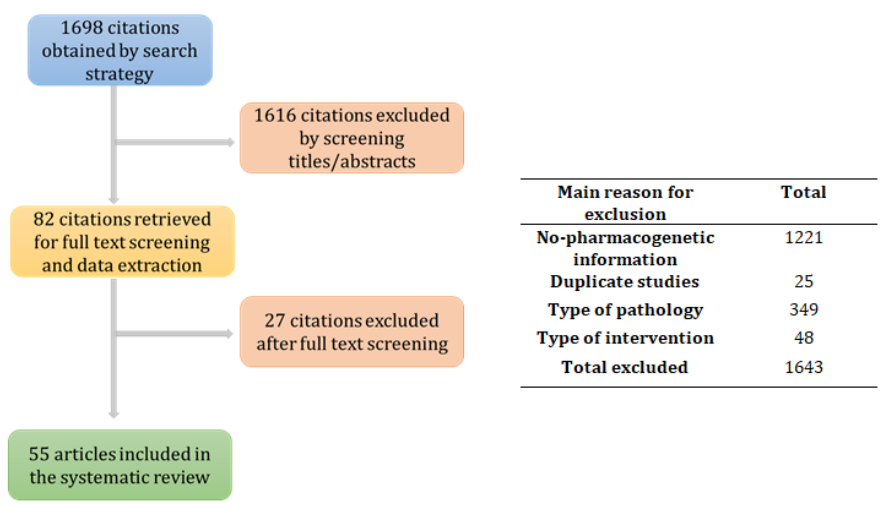
Figure 1. Flowchart of study selection procedure and main reasons for article exclusion.